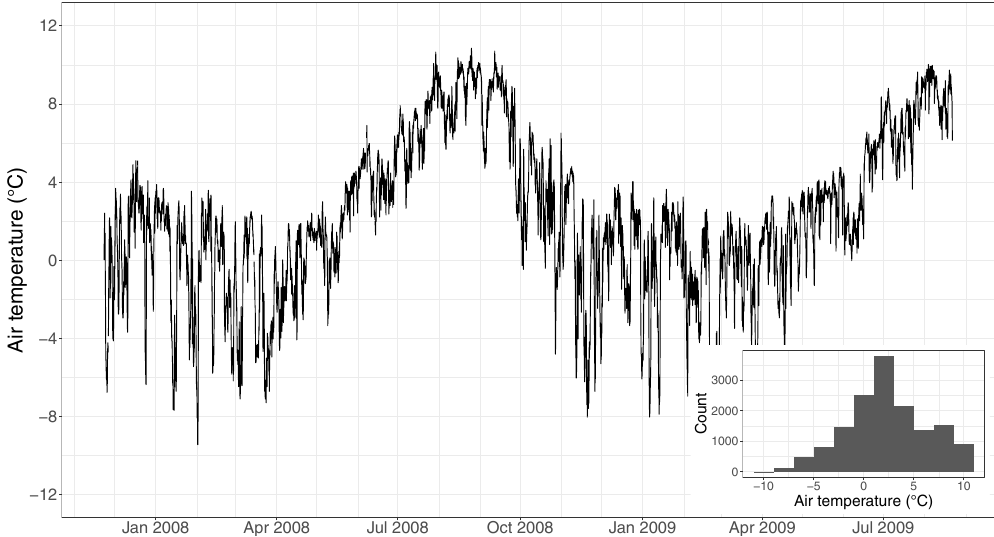
Figure 4. Measurements of air temperature ( ◦ C) at 3.5m height. A histogram of measurements is inset.